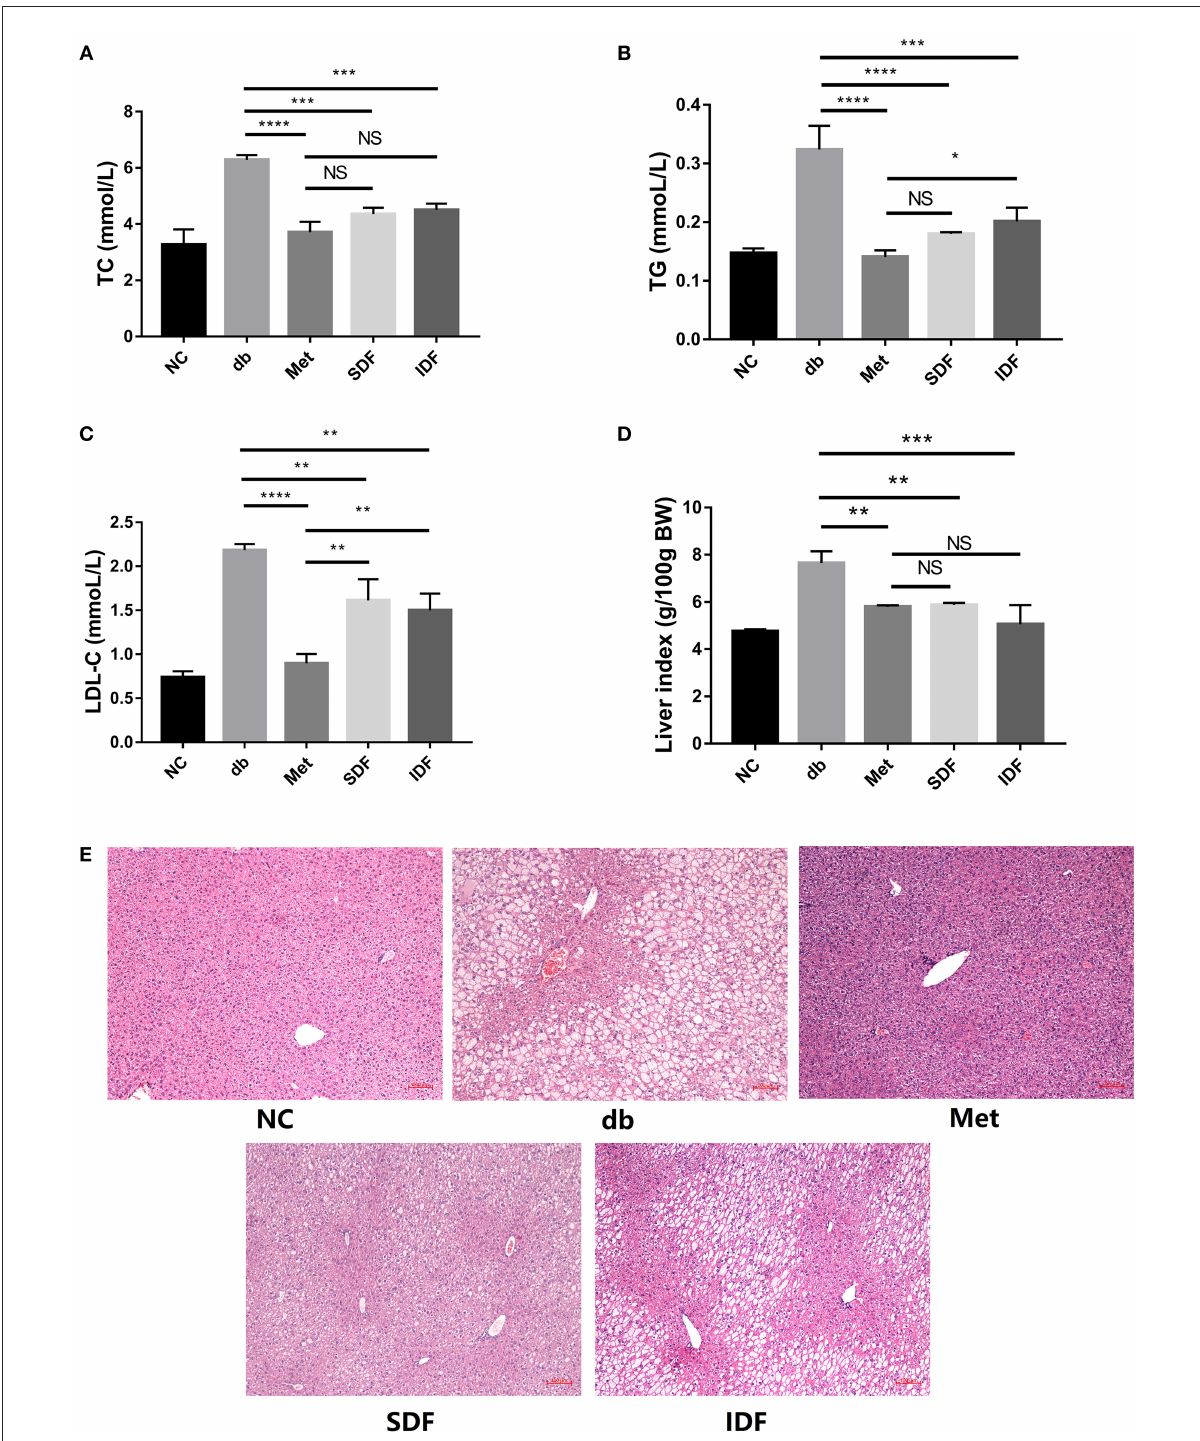
FIGURE5 DF improved glycolipid metabolism in db/db mice. Serum levels of TC (A) , TG (B) , and LDL-C (C) were analyzed by commercial kits at the end of the study. Liver index of the db/db mice (D) . Microscopic images of liver sections (E) . Liver sections were stained by H&E. Bar = 100 µ m. Each value represents the mean ± SD. The results were analyzed using one-way ANOVA and a Tukey post-hoc test; * p < 0.05, ** p < 0.01, *** p < 0.001, **** p < 0.0001, NS: